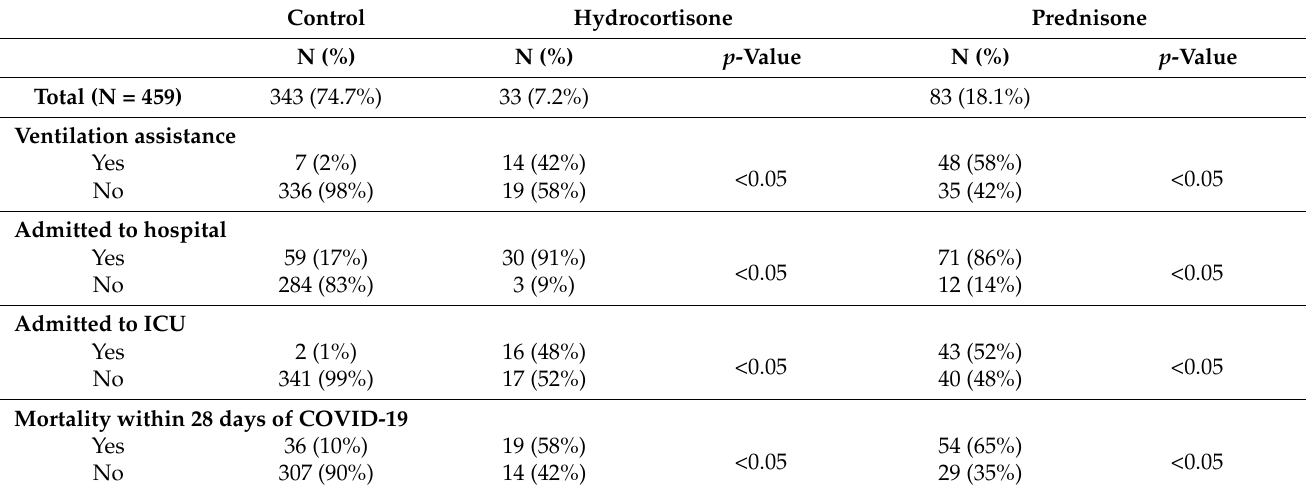
N: sample number. Patients with unknown cancer primary site were excluded from these percentages.